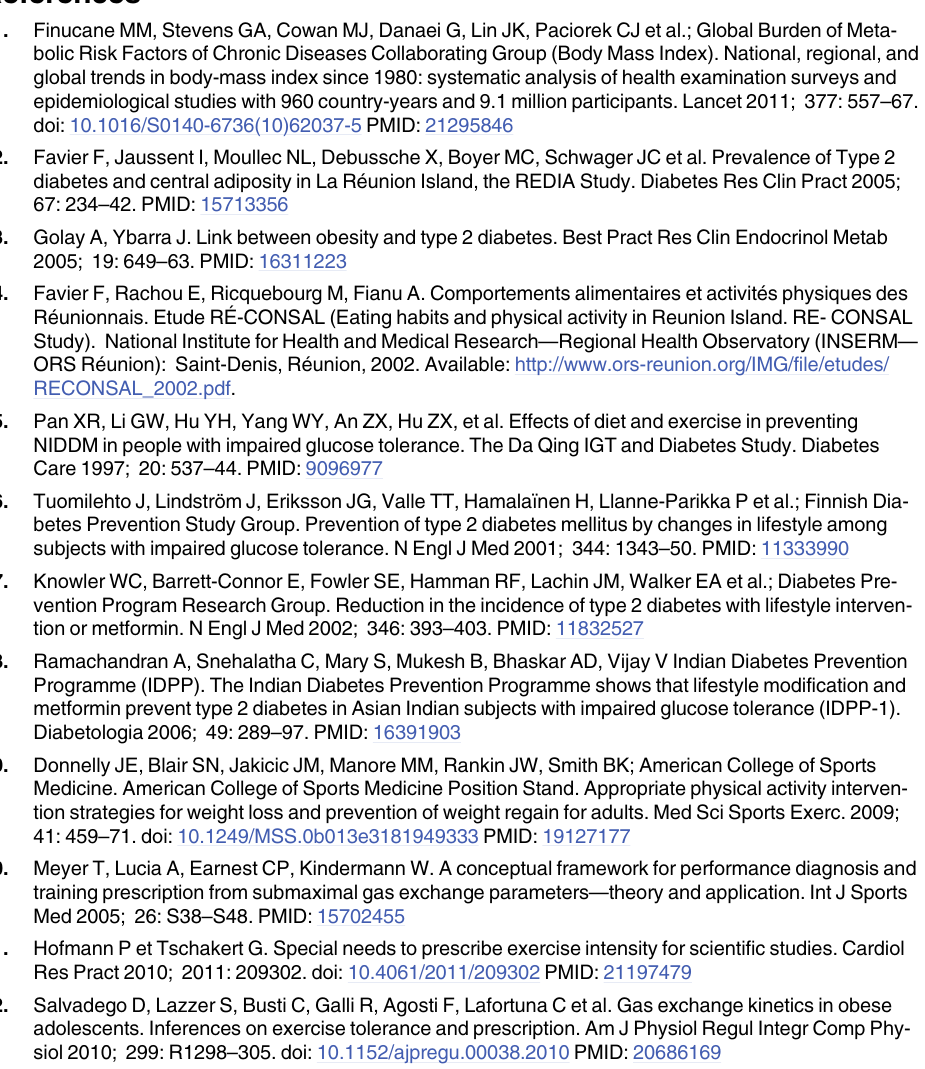
S4 Table. Analysis of bias of selection for exercise tests at inclusion among participants and non-participants at M3 and